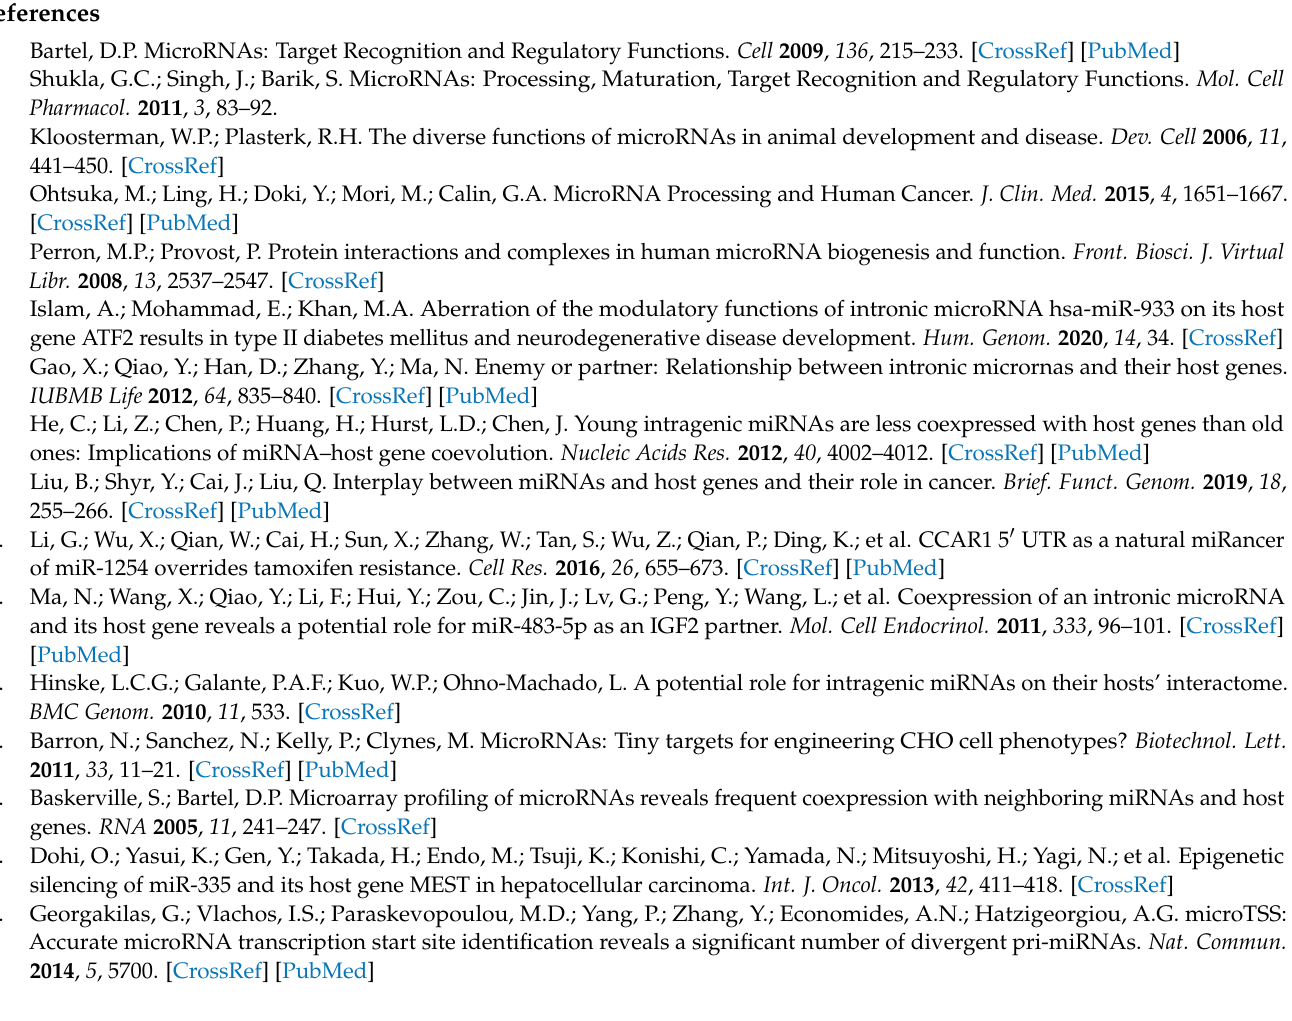
miR-3615 and RAB37/SLC9A3R1. Figure S9: Expression correlation between miR-125b-5p and MIR100HG/MIR99AHG. Figure S10: (A) The survival analysis of FGF13 in LGG. (B) The survival analysis of miR-504-5p in LGG. Figure S11: Expression correlation between miR-504 and FGF13. Table S1: Intragenic miRNA-host gene pairs in human. Table S2: Meta analysis results for miRNA-host gene pair correlations across 21 cancers. Table S3: 79 miRNA-host pairs consistently and strongly coexpressed in all cancer